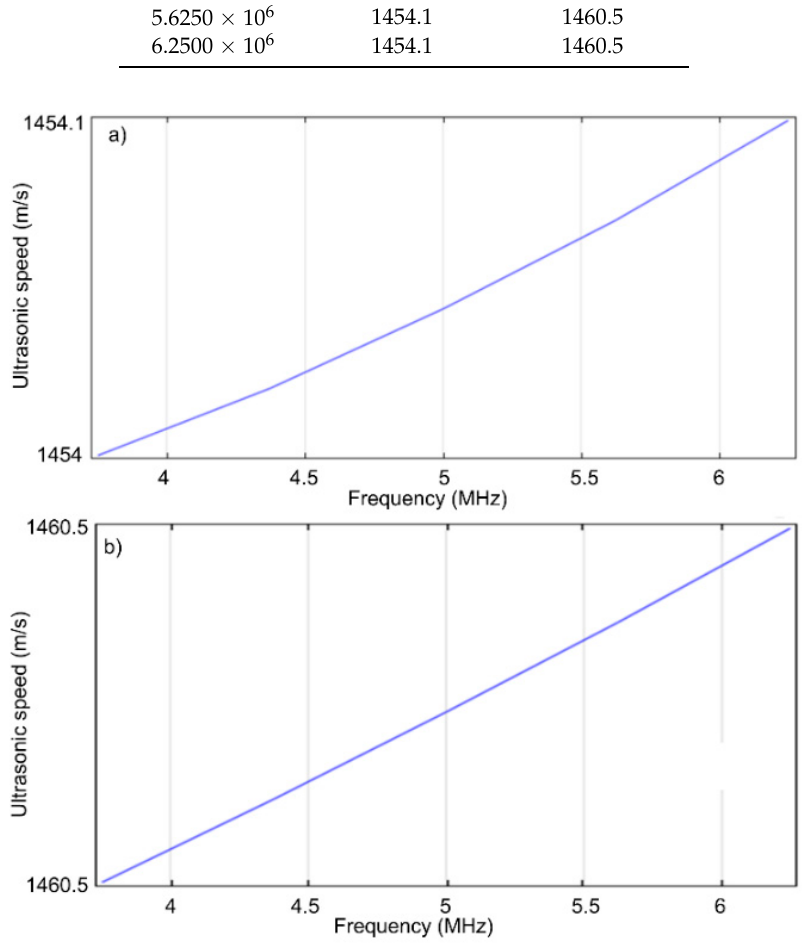
water (blue) ( a ); Acoustic pressure in the biphasic environment for 7ZnHAp (red) for five frequencies